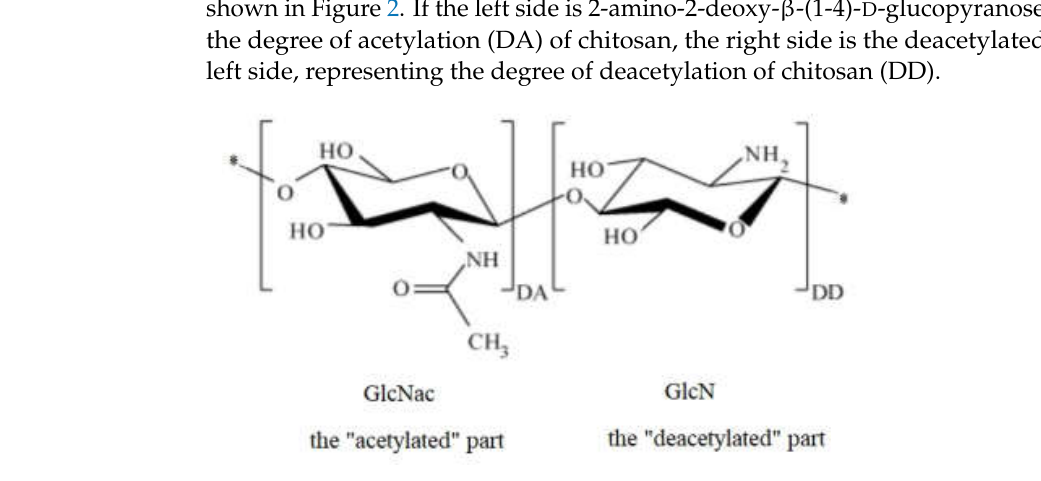
Figure 3. Linear structure of chitosan. The major difference between chitin and chitosan consists of the amino groups (Figure 4). Thus, their physicochemical properties, which are correlated with their